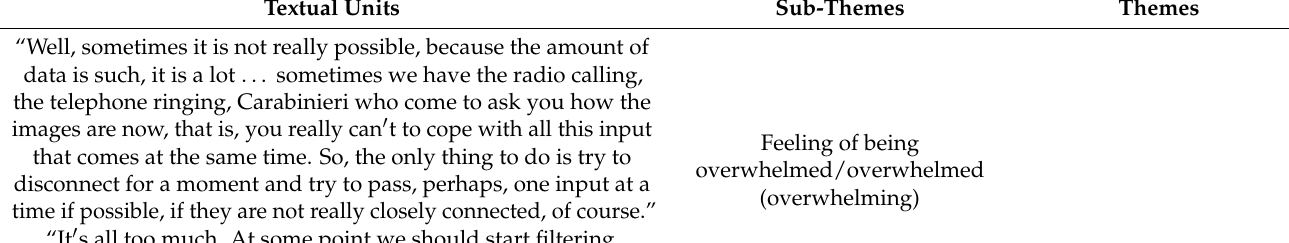
Table 3. Textual units, subthemes and themes. Examples from interviews ( n = 39). Textual